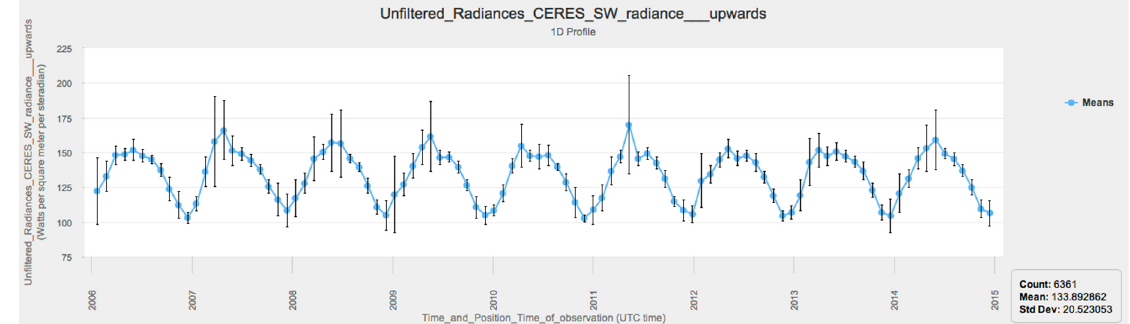
Figure 10. MIIC Analysis Plugin Results, CERES SW unfiltered radiance over Libya-1; nine years of CERES data collected and analyzed using MIIC; 1233 events detected, and 6361 CERES observations are processed; data are filtered for θ s < 60 ◦ and θ v < 30 ◦ .